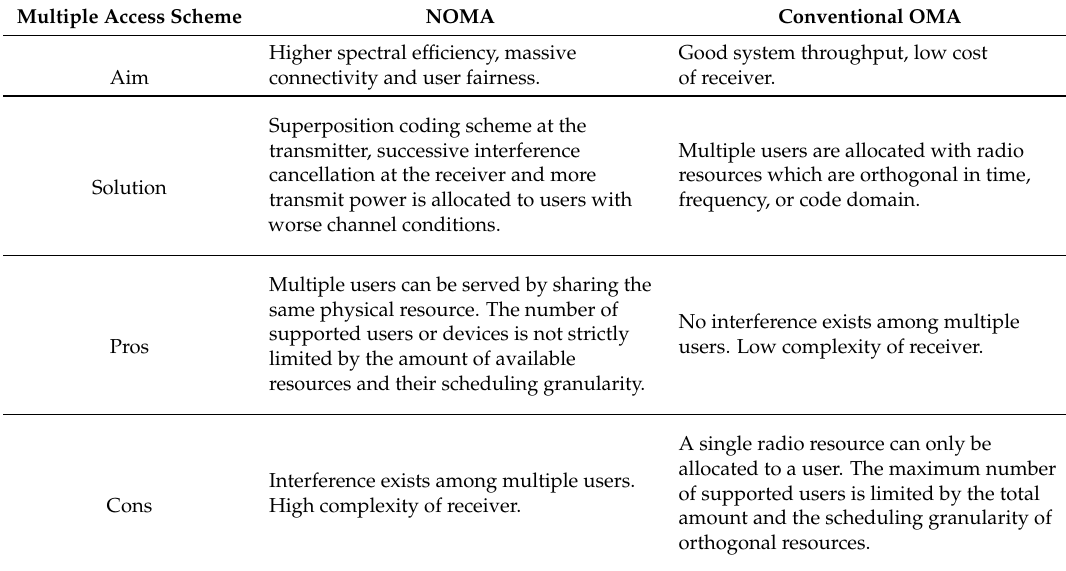
Table 1. The comparison of non-orthogonal multiple access (NOMA) and conventional orthogonal multiple access